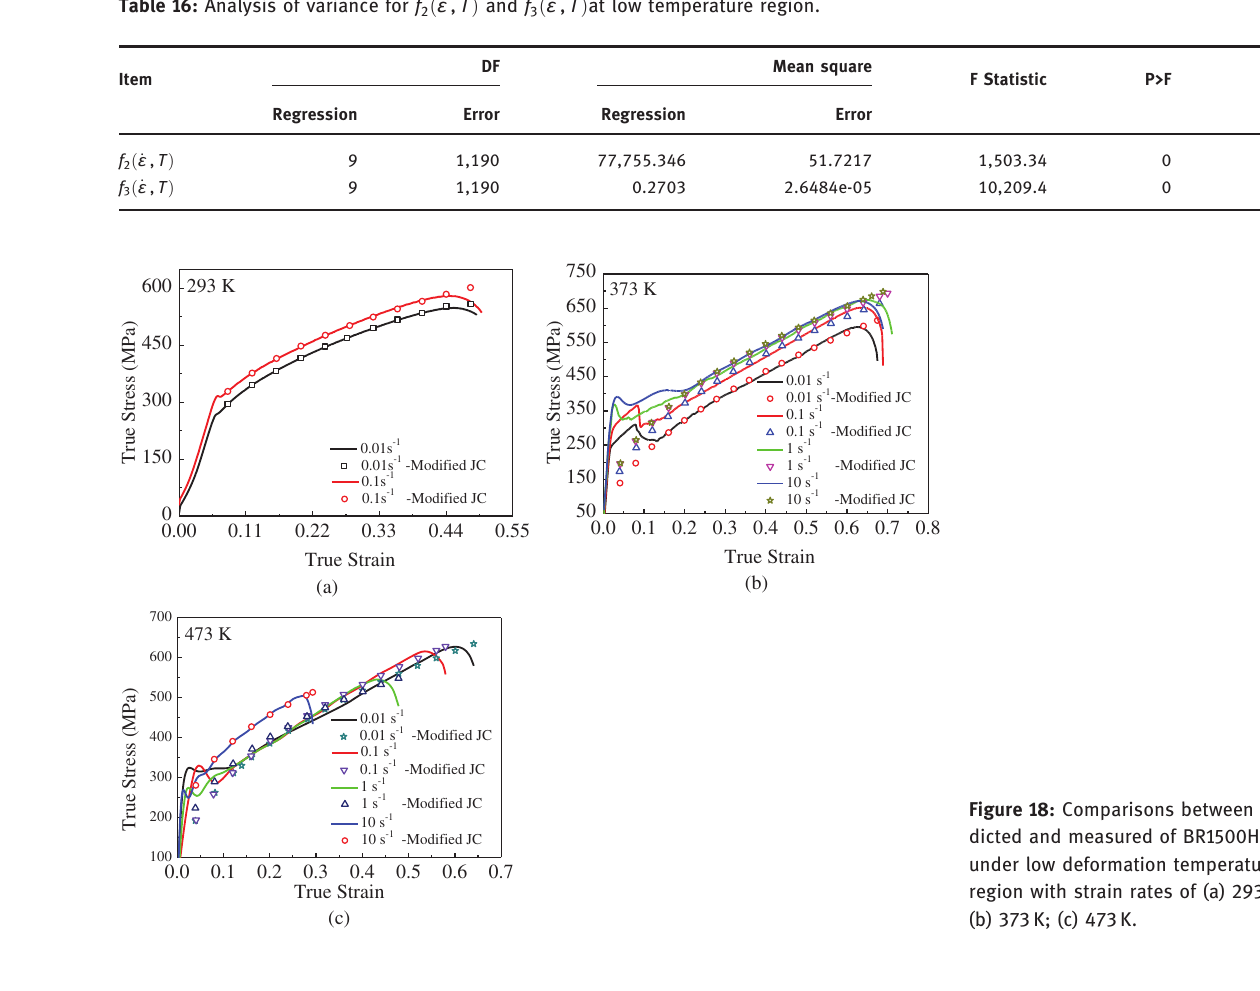
Table 17: The relative error between the calculated and experimental results under low deformation temperature region with different strain rates at specific strain.